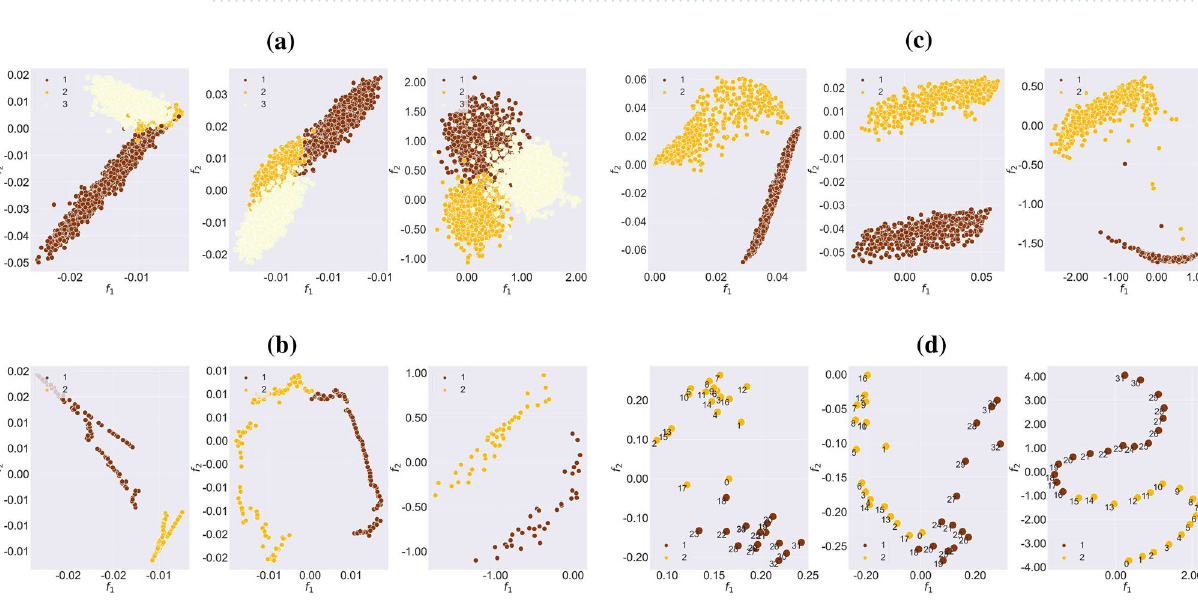
Figure 5. The graph embeddings of the time-evolving graph G for ( a ) npos_2WellGraph, ( b ) pos_3WellGraph, ( c ) MovingPic and (d) CholeraInf. From left to right: PCA on adjacency matrices, PCA on eigenfunctions of graphKKE and the result of our